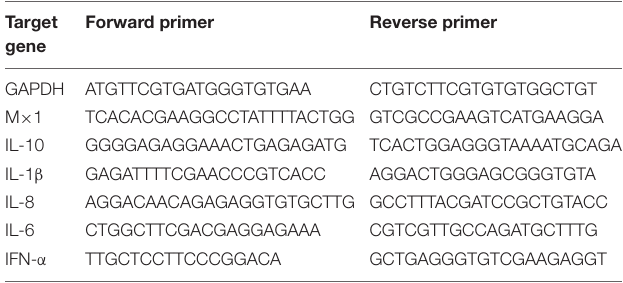
TABLE 3 | Primers of qRT-PCR for detection of cytokine mRNA level in the lungs of mallard ducks. Target